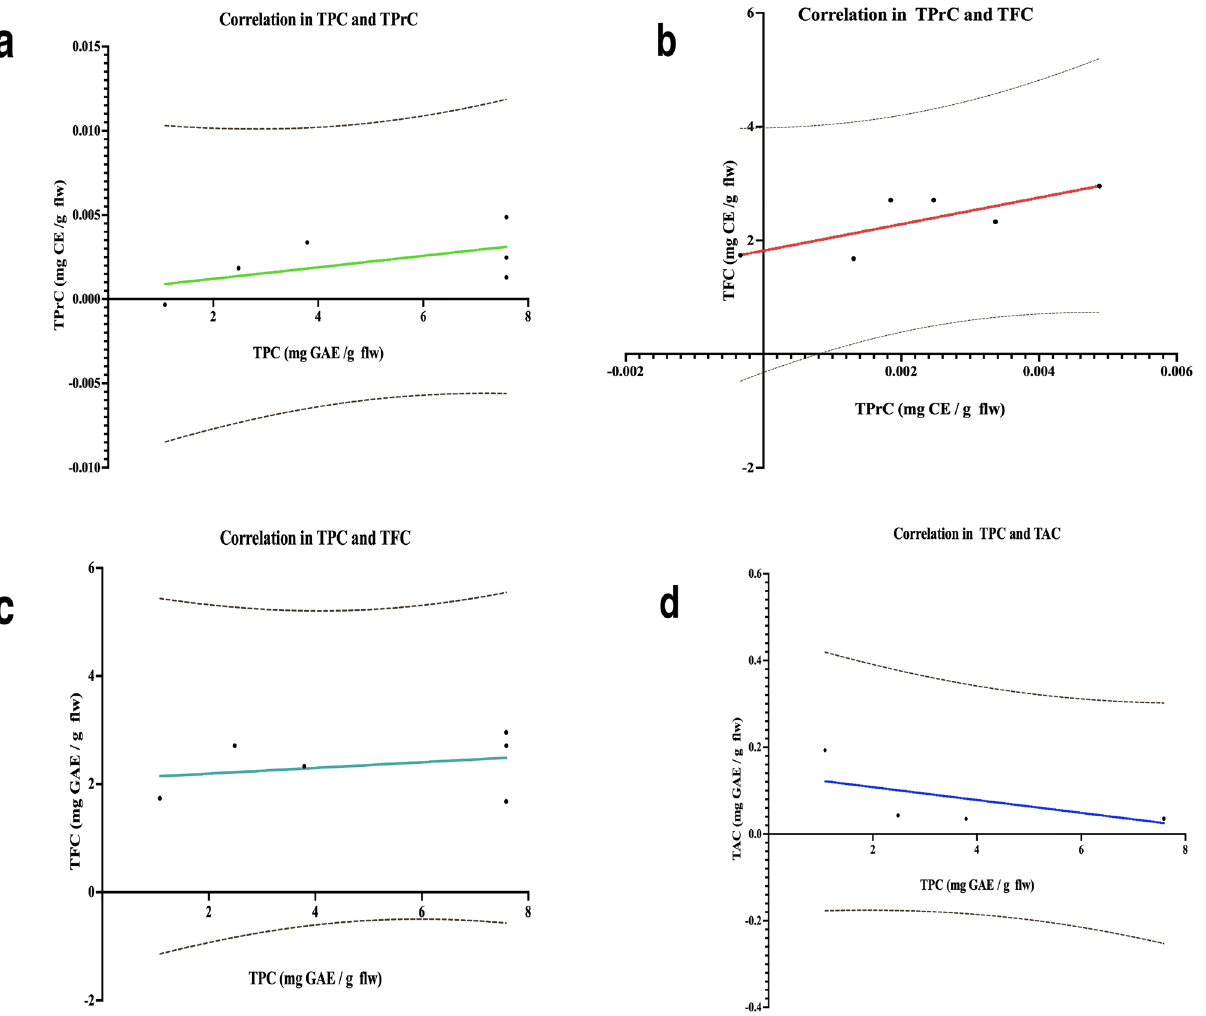
Figure 3. Linear regression in secondary metabolites of lingonberry shoots in vitro and plants under ex vitro condition. Data were analyzed based on means ± SD, n = 6. Significant differences not present at α = 0.05 by Spearman test. ( a ) Correlation between TPC and TPrC. ( b ) Correlation between TPrC and TFC. ( c ) Correlation between TPC and TFC. ( d ) Correlation between TPC and